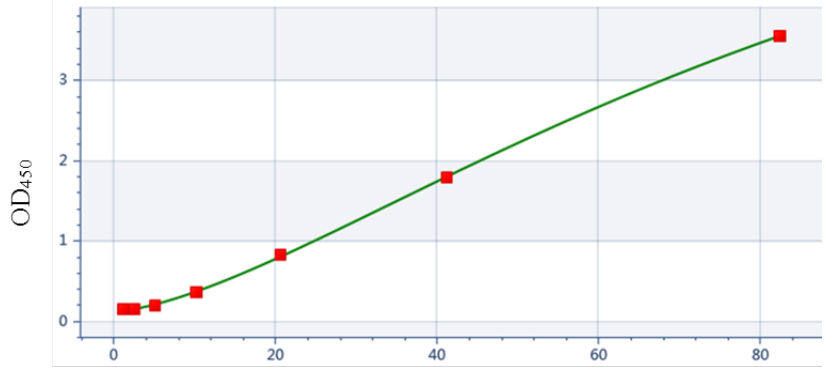
Figure 4. Quantitative curve of PPI.